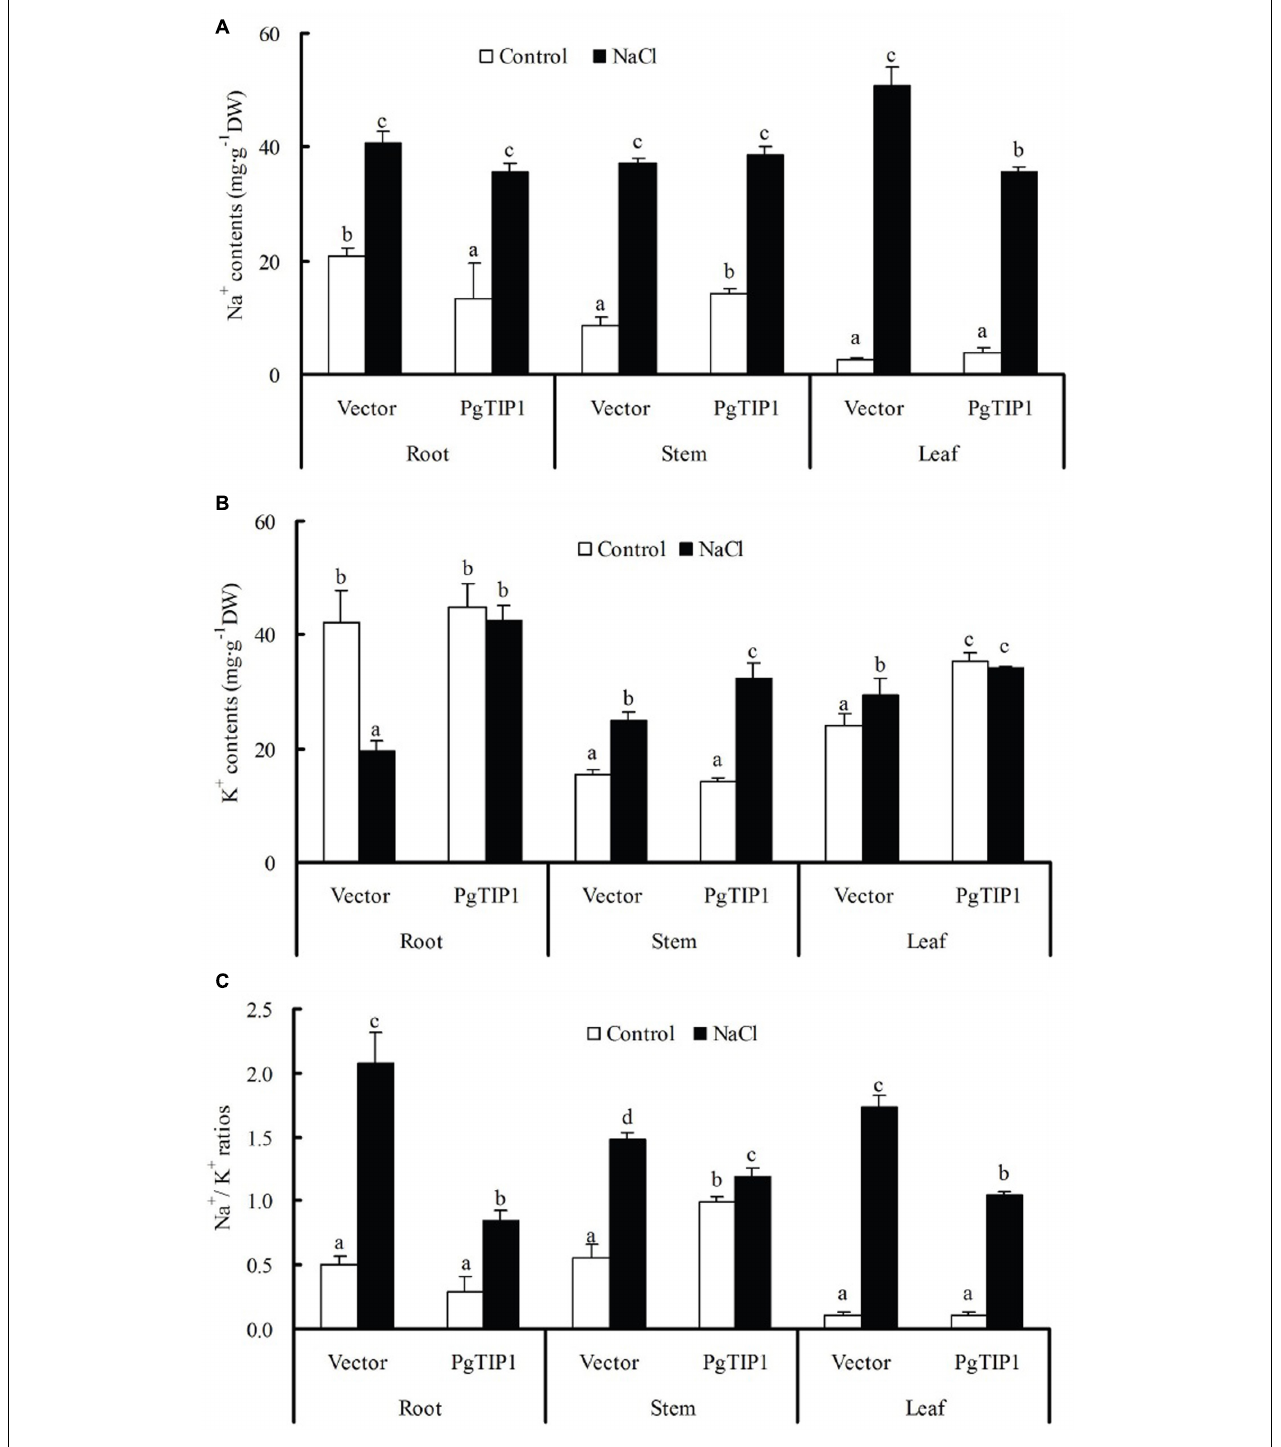
FIGURE 3 | Changes in contents of (A) Na + , (B) K + , and (C) Na + /K + ratios in roots, stems and leaves of the empty vector - transformed and PgTIP1 -transformed soybean hairy root composite plants under salt stress. The seedlings with hairy roots of a similar-length were selected and treated with 1 / 2 Hoagland solution containing 120 mM NaCl for 5 days, and seedlings grown in 1 / 2 Hoagland solution without NaCl served as the untreated control. During this period, the solutions listed above were replaced once. The sampled leaves included the 1st pair of unifoliolate, the 1st and 2nd trifoliate leaves. Each bar represents the mean and SD of three replicates, means in bars followed by different letters show significant difference ( P < 0.05) between the parameters of the empty vector - transformed and PgTIP1- transfromed soybean hairy root composite plants.